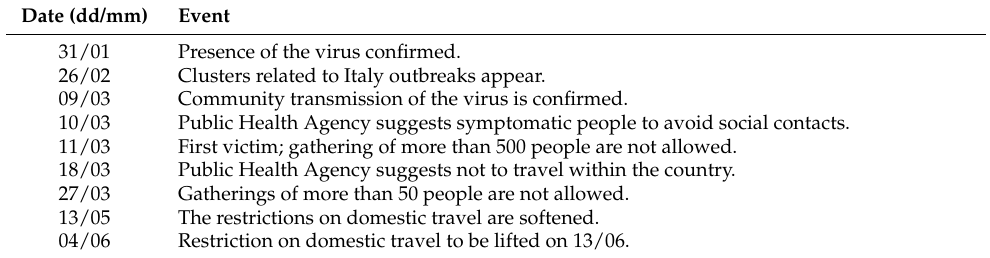
Table 7. Events and policies timeline related to the COVID-19 epidemic situation in